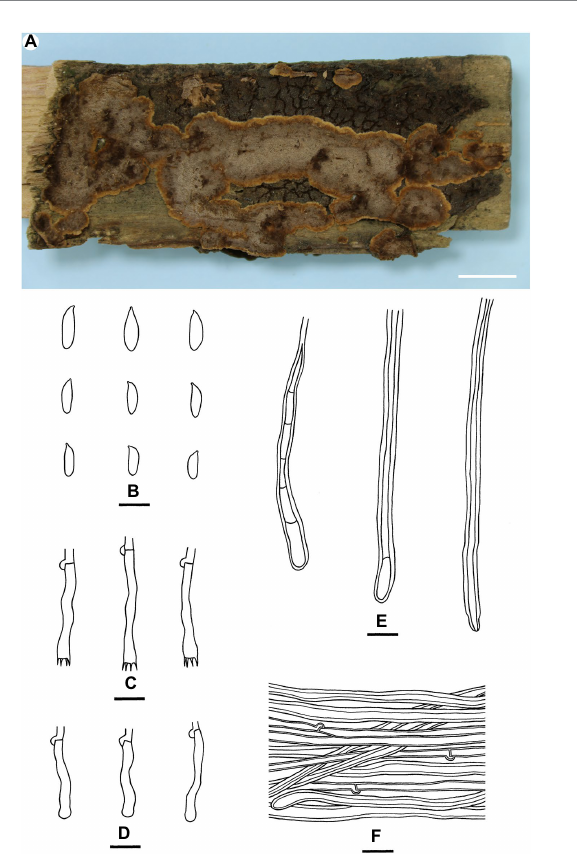
FIGURE 4 Veluticeps subfasciculata (from the holotype He 2979; scale bars: a = 1 cm; b– f = 10 μ m). (A) Basidiomes; (B) Basidiospores; (C) Basidia; (D) Basidioles; (E) Skeletocystidia; (F) Hyphae from